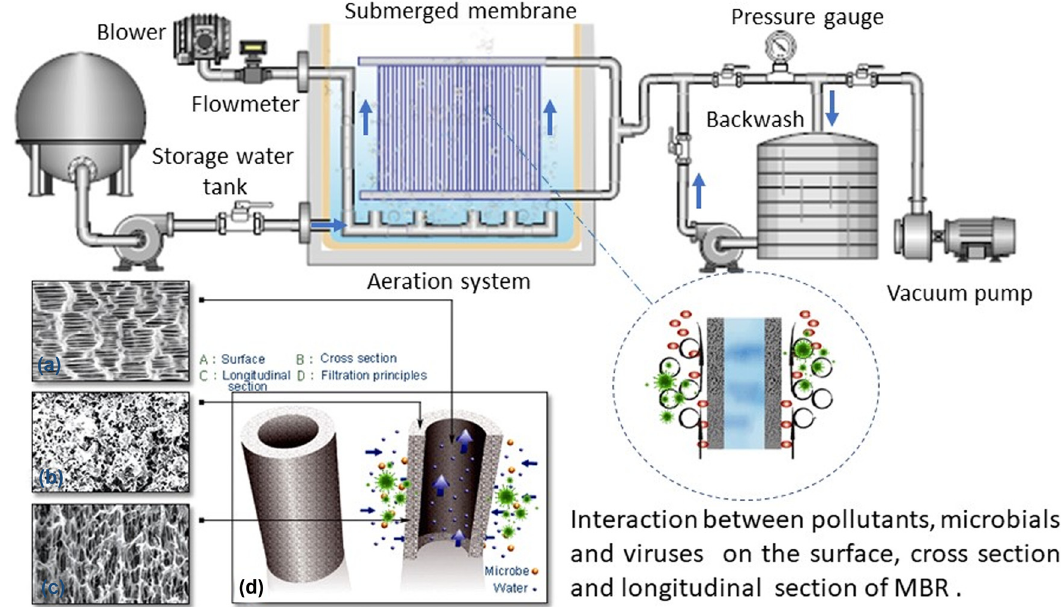
Figure 9: Membrane bioreactor ( MBR ) for virus